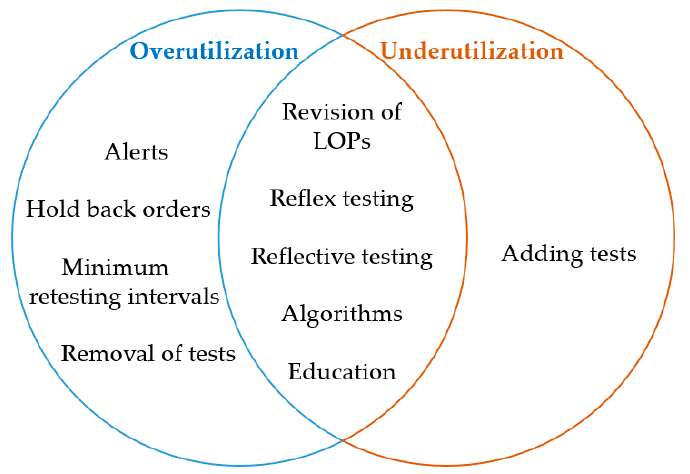
Figure 1. Categorization of DM strategies: Stratification of whether DM tools prevent overutilization and/or underutilization. LOP = laboratory ordering profile.